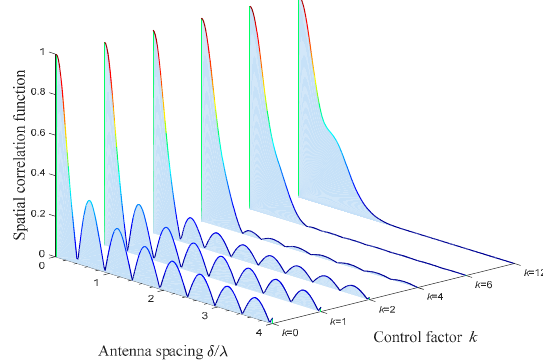
Figure 7. Analytical results of the spatial CF ρ pq , p’q’ ( δ T , δ R ) of the proposed model for different antenna spacings δ / λ and different control factors for the distribution concentration k .